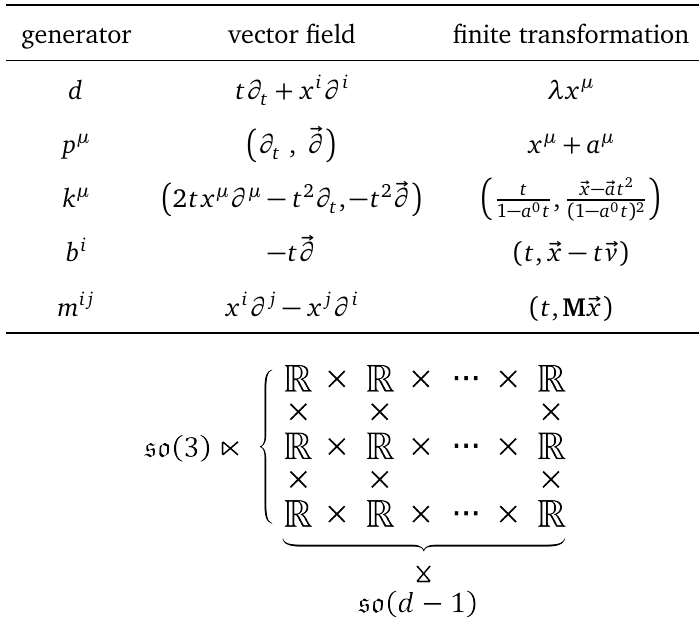
Figure 1: Structure of Galilean conformal